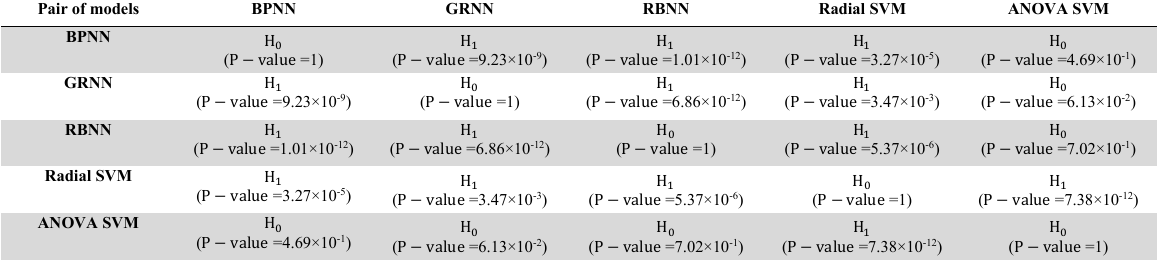
Statistical comparison between the machine learning models for heating loads prediction based on two- tailed Student’s t-test